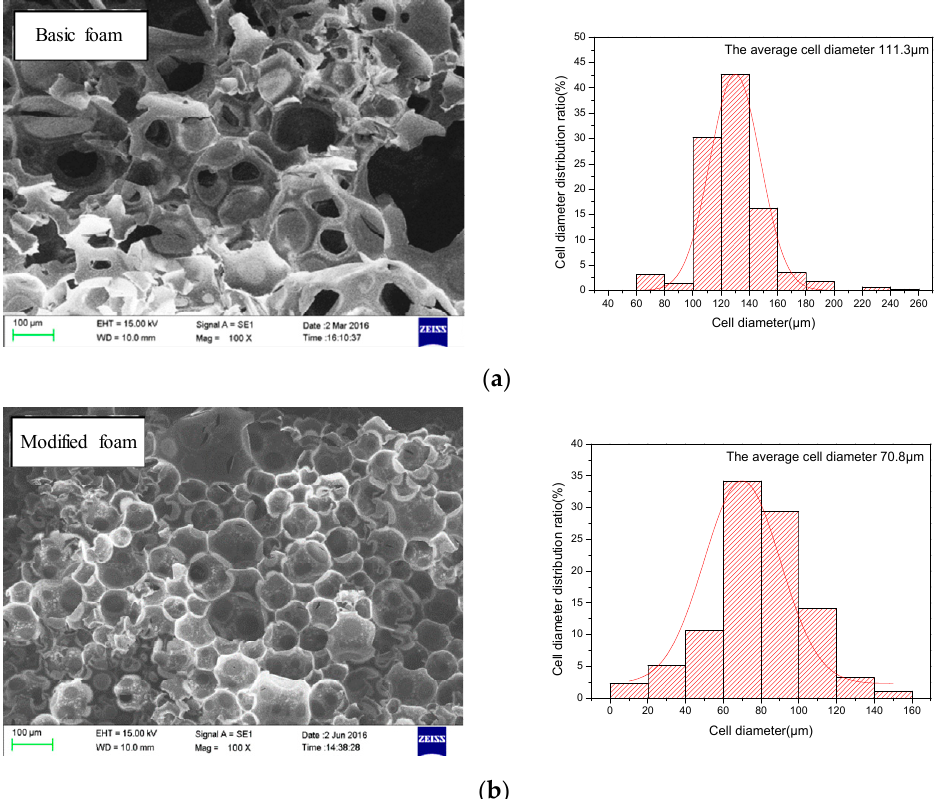
Figure 11. The SEM and cell diameter distribution of foam ( a ) basic foam; and ( b ) modified foam with the amount of acetoacetic ester-terminated polyether being 16% of the amount of phenol.